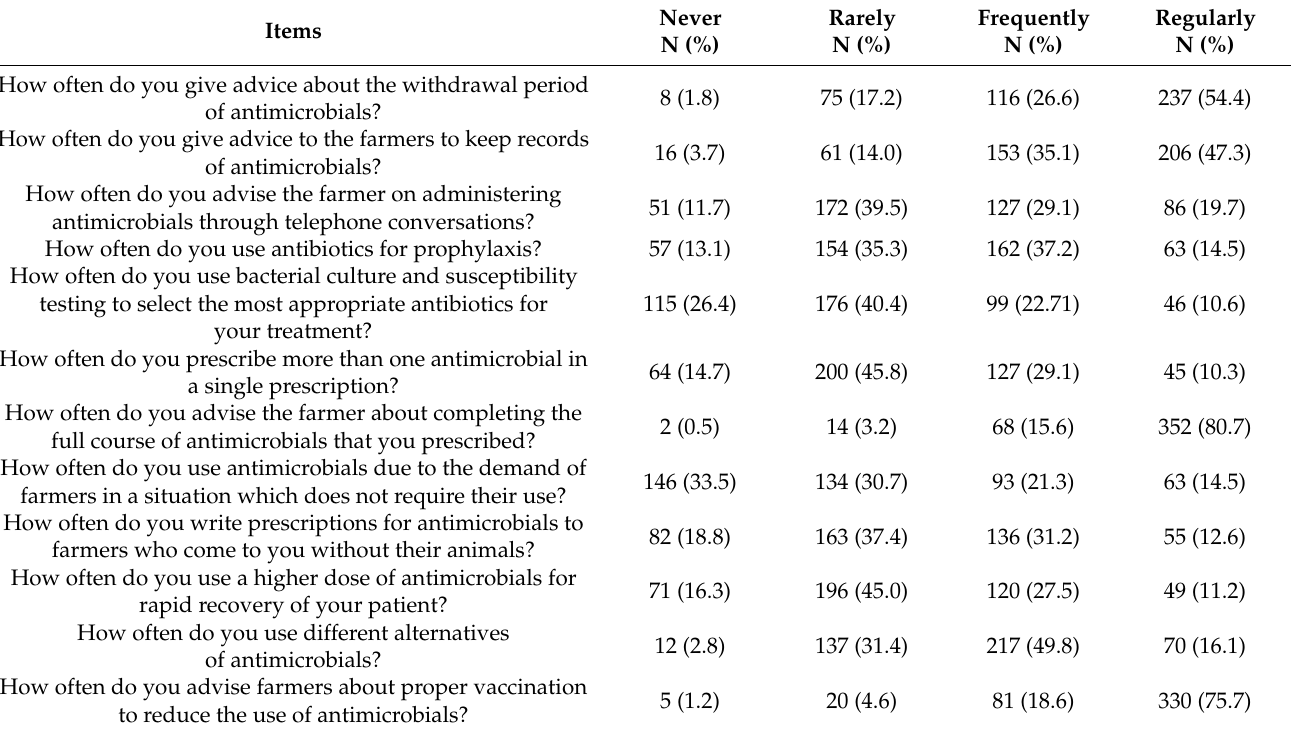
Table 4. Practices of veterinarians on AMU and AMR.